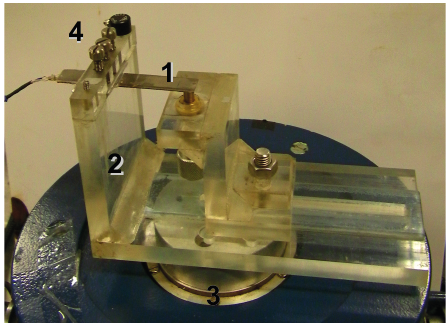
Figure 5. Experimental setup for the analysis of the vibration energy harvester prototype